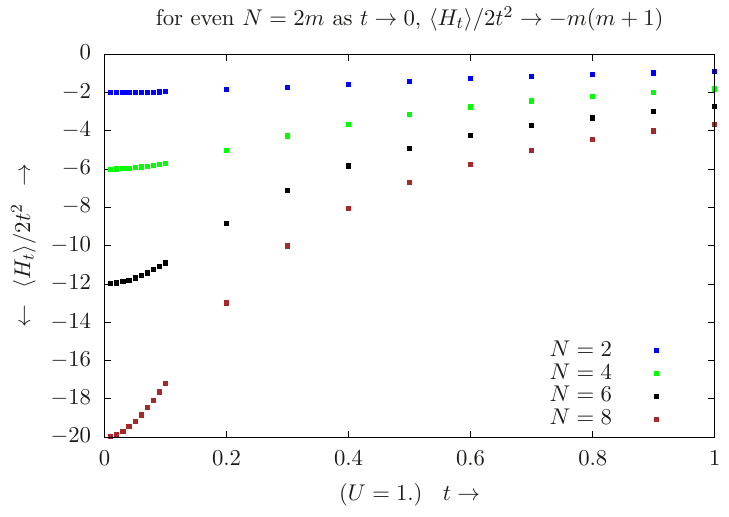
Figure 10 . Hopping VEV for even N = 2 m